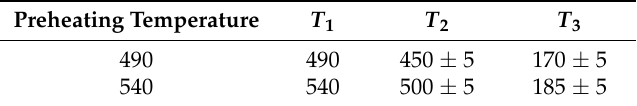
Figure 1. ( a ) Schematic diagram; ( b ) temperature change of hot rolling-quenching integrated process with cold rolls. Table 2. The temperature during rolling-quenching integrated process (°C).